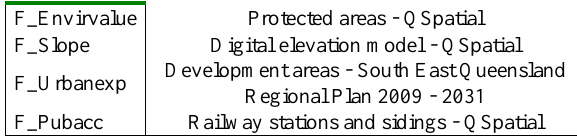
Table 1 . Selected factors and data source.